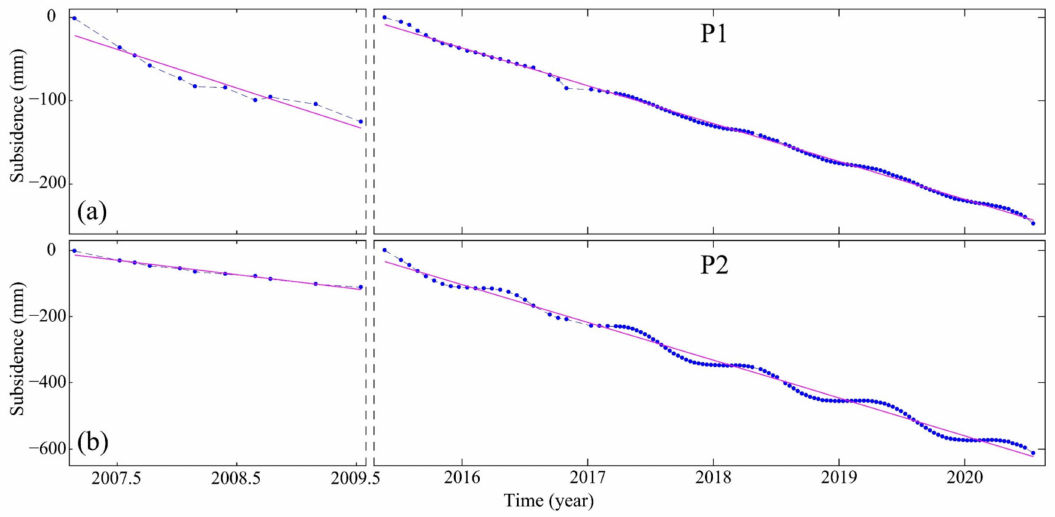
Figure 6. The time-series cumulative deformation at P1 and P2 in Figure 4. The blue dots represent the InSAR observations. The magenta lines are the linear fitting results of the corresponding InSAR